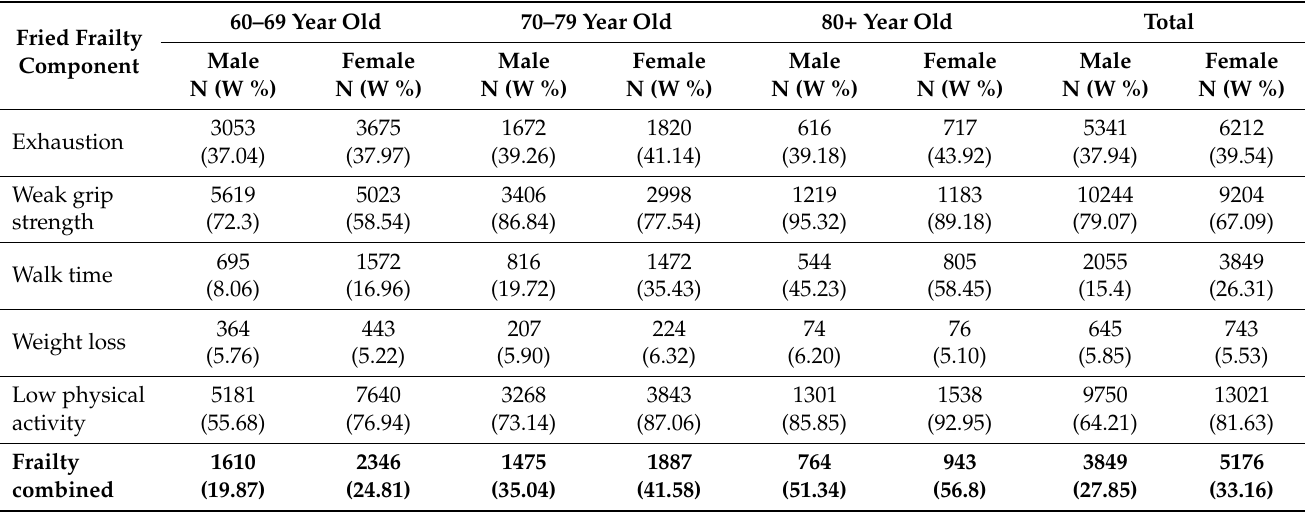
Table 2. Prevalence of frailty phenotype by age group and gender in India, 2017–2018.